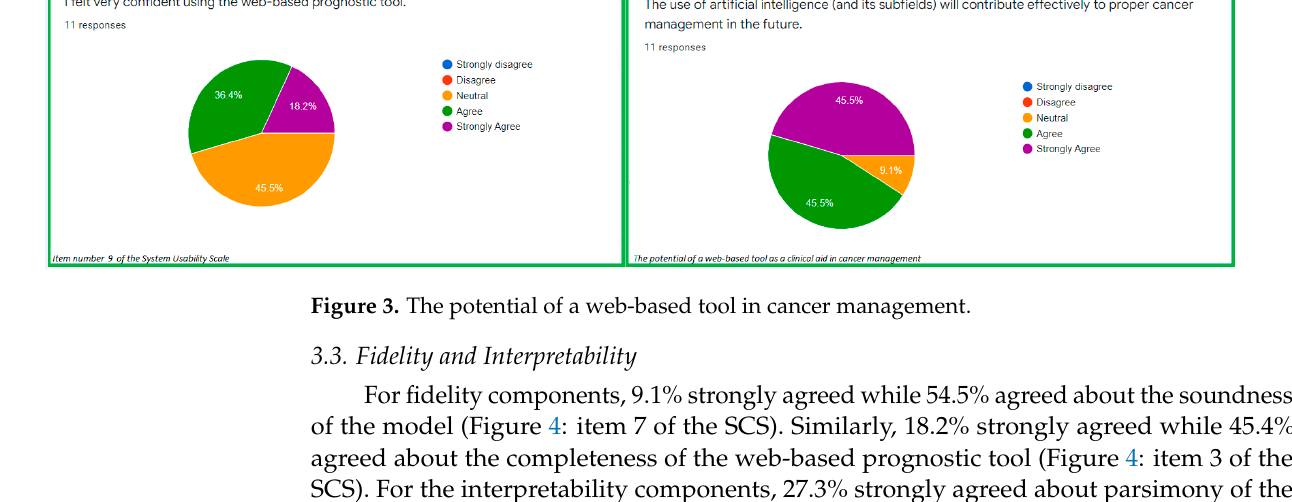
Figure 2. The explainability of a web-based prognostic tool using items number 2 and 8 of the Sys- tem Causability Scale.